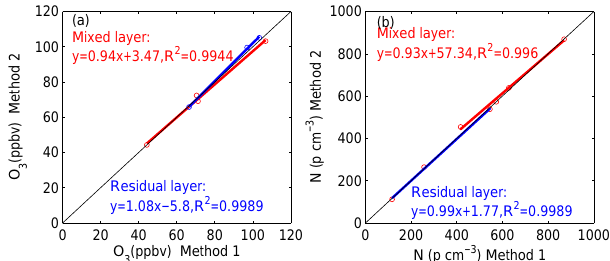
Figure 6. Average O 3 mixing ratios (a) and aerosol number con- centrations (b) in the mixed layer and residual layer obtained using the method of particle extinction gradient (method 1) in comparison with those obtained using the method of particle number concentra- tion gradient (method